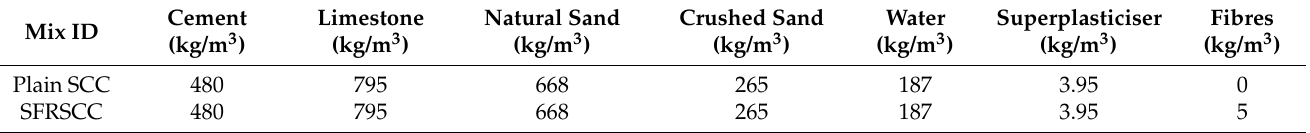
Table 1. Mix proportions of plain self-compacting concrete (SCC) and steel-fibre-reinforced SCC (SFRSCC). Mix